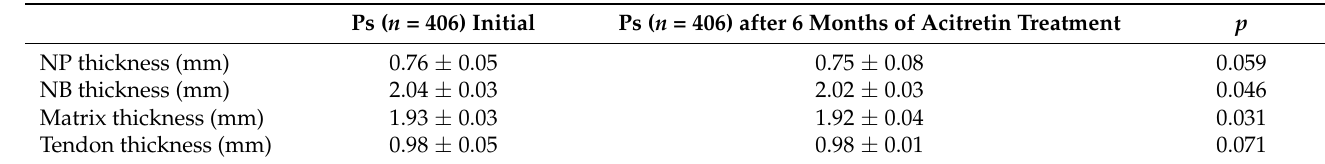
Table 3. US measurements of the nails in patients studied.